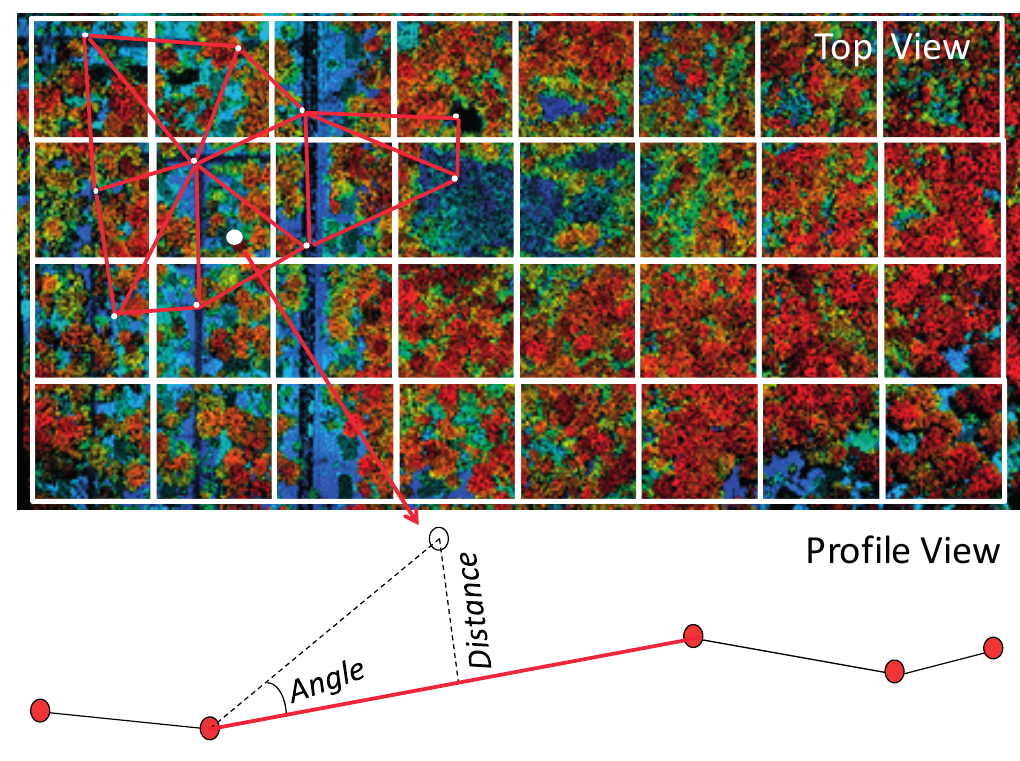
Figure 18. Axelsson’s ground classification algorithm